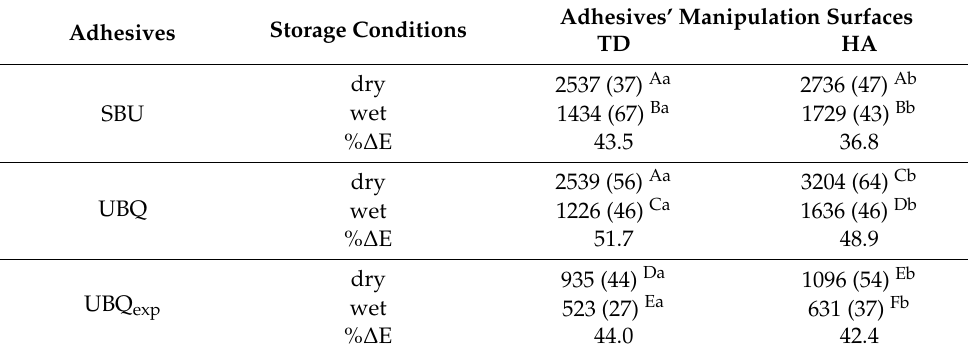
Table 5. Mean (SD) values (MPa) of the modulus of elasticity ( n = 8).